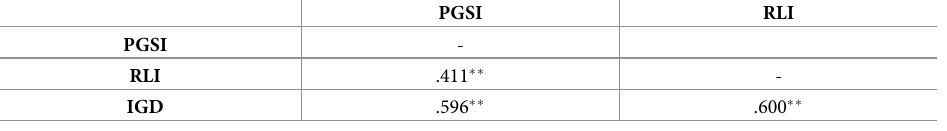
Table 2. Relationships (Pearson’s r) between impulse control disorders: Problem Gambling Symptomology (PGSI), the Risky Loot Box Index (RLI), and IGD